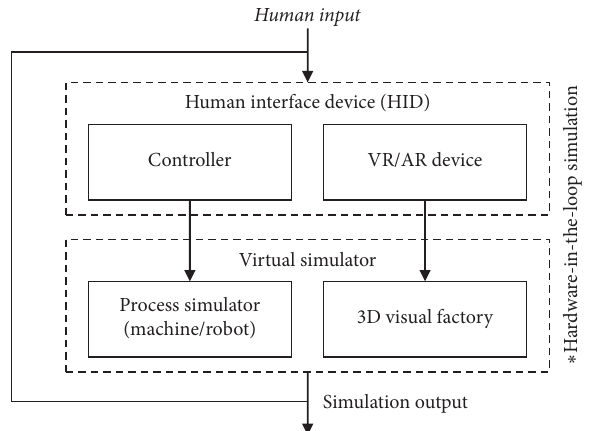
Figure 4: Concept of virtual simulation in smart manufacturing.